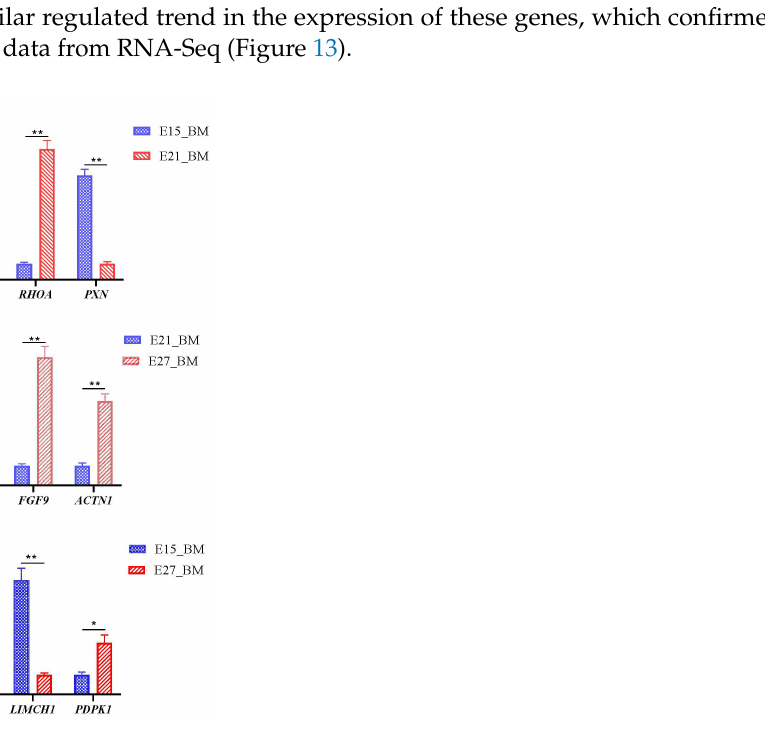
Figure 13. Validation of differentially expressed genes. ( A ) E15_BM vs. E21_BM; ( B ) E21_BM vs. E27_BM; ( C ) E15_BM vs. E27_BM. “*” was considered significant difference ( p < 0.05); “**” was considered extremely significant difference ( p <